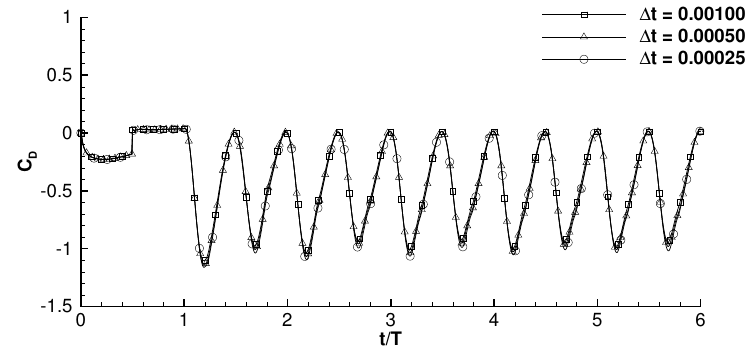
Figure 5. Time step independence